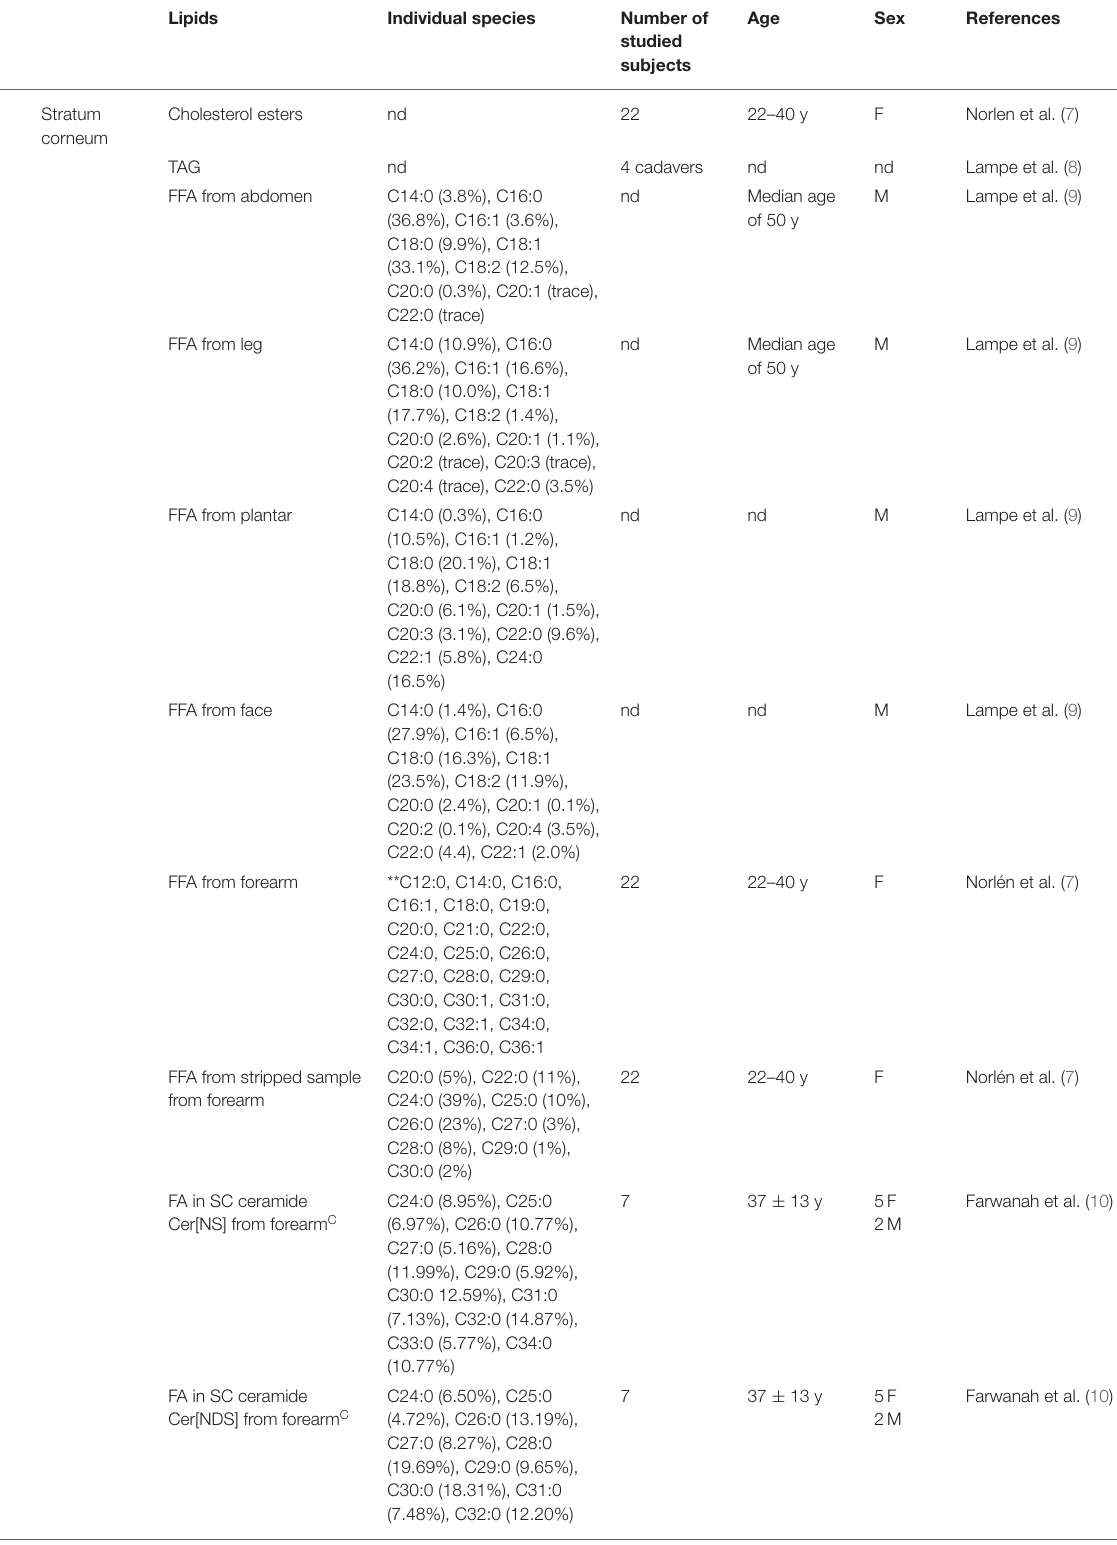
TABLE 1 | The composition of skin lipids in particular skin